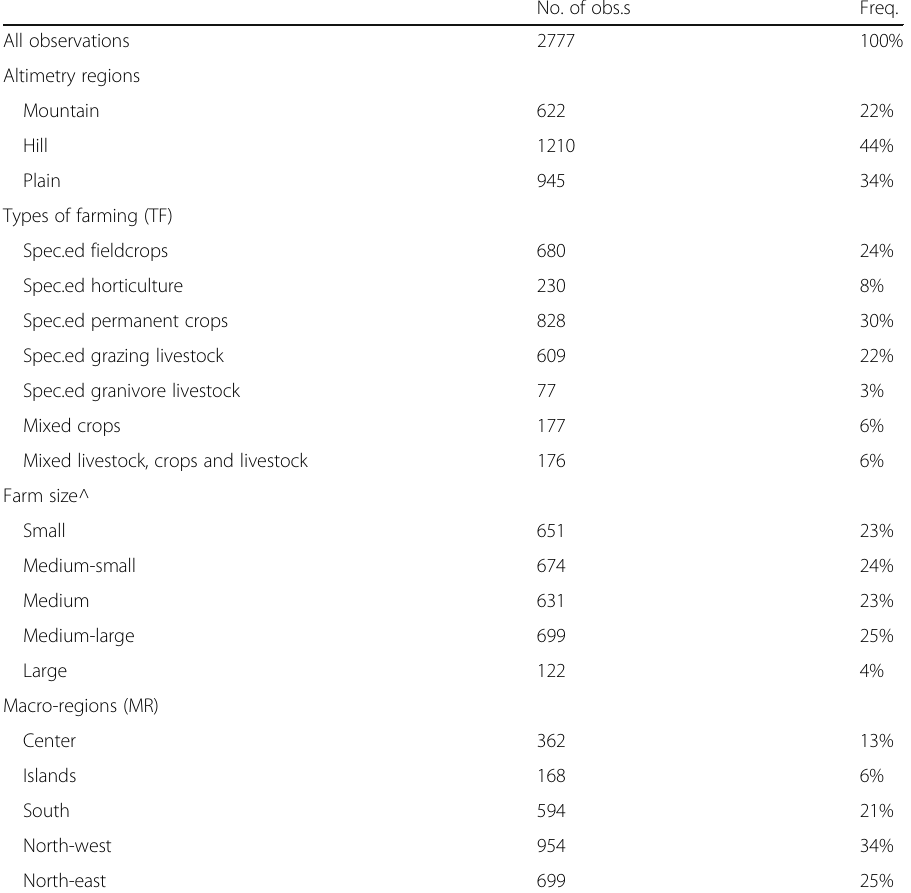
Table 2 Number of the sampled farms and their distribution among altimetry regions, types of farming, farm size, and macro-regions of Italy. Balanced sample (year 2015) No. of obs.s